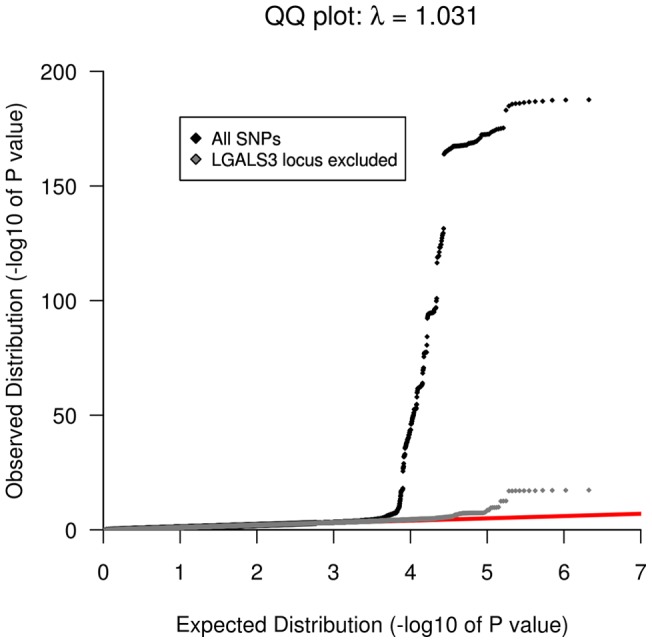
Quantile-quantile plots of observed versus expected p-values for Galectin-3 with and without the GALS3 locus.